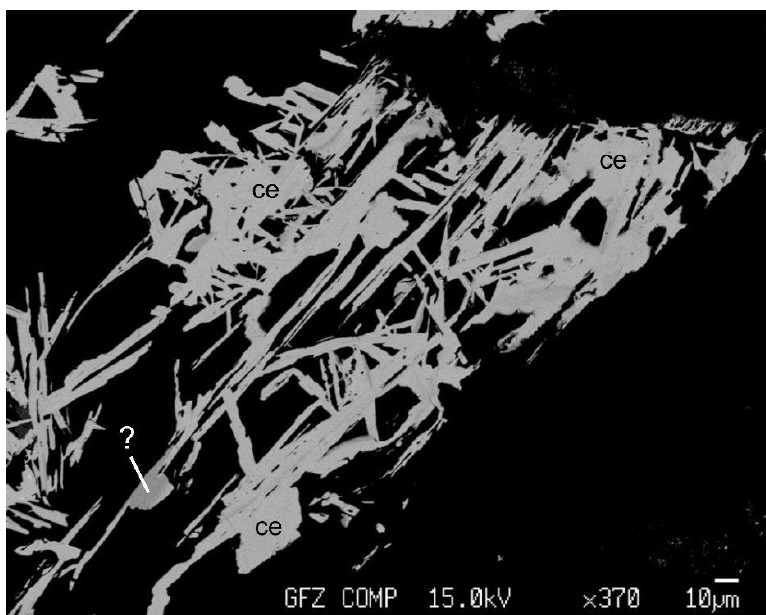
Figure 4. BSE image of parallel-intergrown type-II cerromojonite (ce) grains with darker domains of an unknown Cu–(Ag)–Hg–Pb–Bi selenide. The biggest grain of this potentially new species is marked by a question mark.